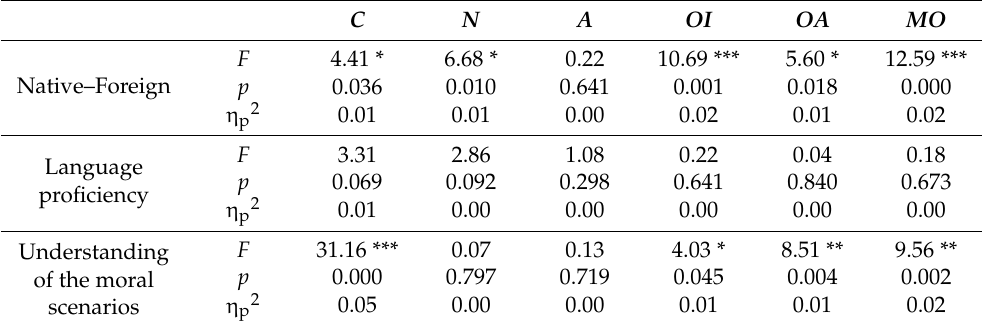
Table 3. The MANOVA results in the combined sample (n = 634).